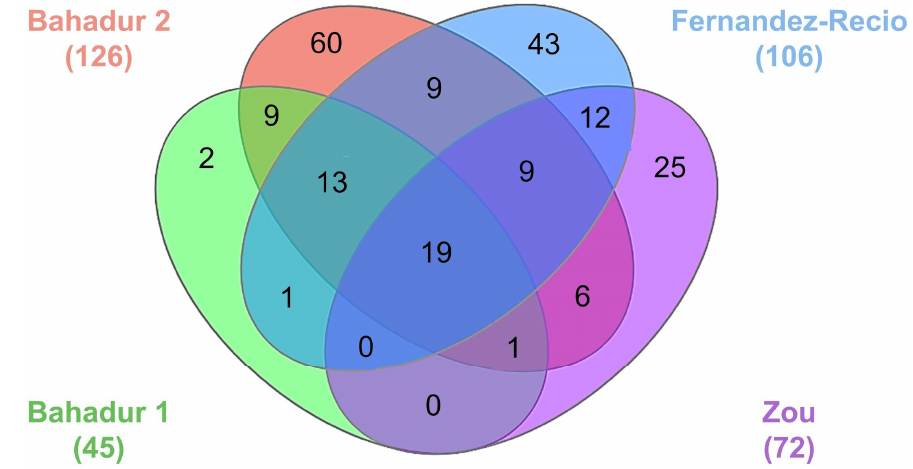
Figure 3. The relationship between RNP docking benchmarks datasets. Nineteen RNP structures are common to all four benchmarks. Two hundred nine RNP structures are represented by all four benchmarks together.